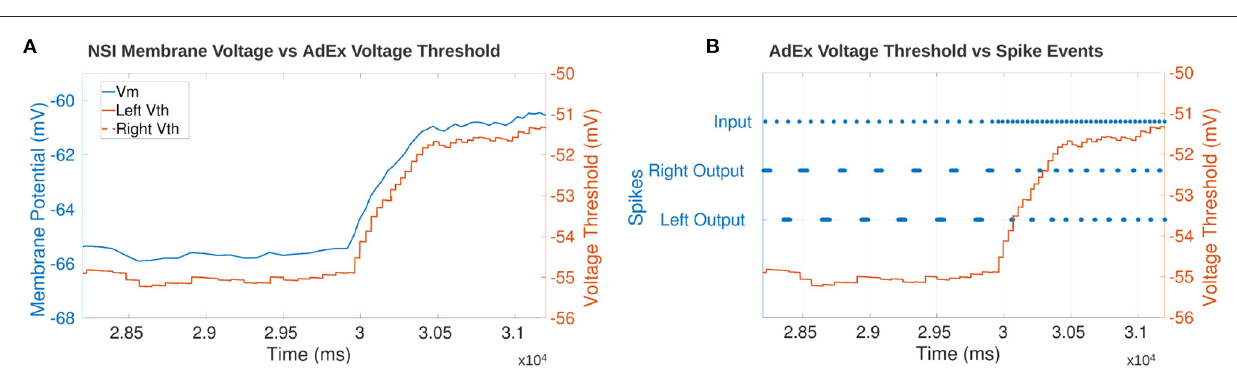
FIGURE 12 | (A) Comparison of the NSI’s V m to the post-synaptic AdEx neuron’s V th . The plot shows V th follows V m confirming that the neuronal characteristics are updated based on the membrane potential of the NSI. The AdEx neurons are defined as “left” and “right” based on their relative position in the sCPG. There is no noise on the synapses to the AdEx neurons so the V th of each neuron follows each other exactly thereby obscuring the view of the right neuron underneath the left. (B) Comparison of each AdEx neuron’s V th to the input and output spike events. The spikes are not rate-coded because there is only one neuron per population. V th increases when the input spike events increase which leads to an increase in bursting frequency of the AdEx neuron. The left and right neurons spike 180 ◦ out of phase as expected based on the sCPG architecture of mutual inhibitory coupling.